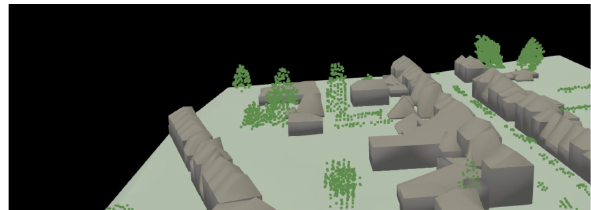
Figure 5. 3D city model in which SolitaryVegetationObject are rendered as MultiPoint